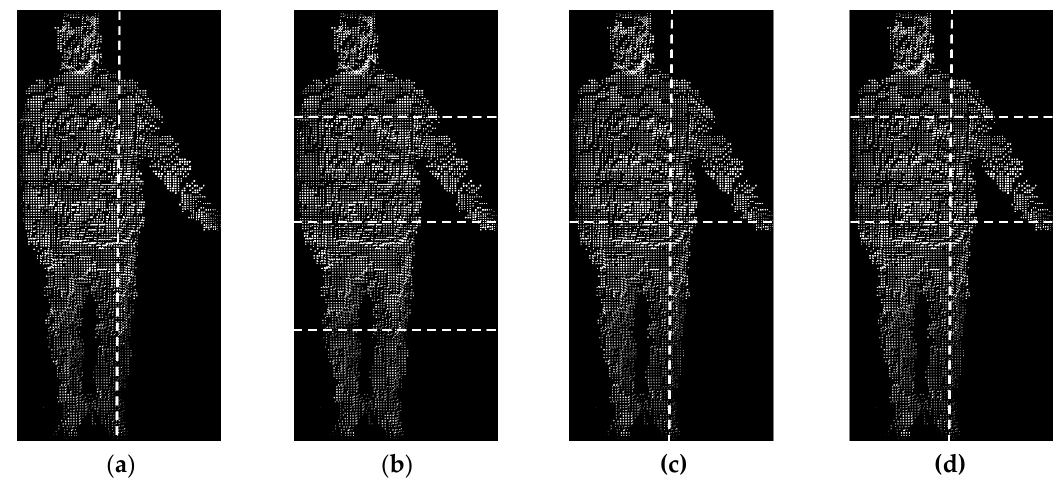
Figure 7. The considered decompositions of the person bounding box: ( a ) vertical division into two Figure 7 . The considered decompositions of the person bounding box: (a) vertical division into two cells, (b) cells, ( b ) horizontal division into four cells, ( c ) cross-division into four cells, ( d ) division into six cells. horizontal division into four cells, (c) cross-division into four cells, (d) division into six cells.